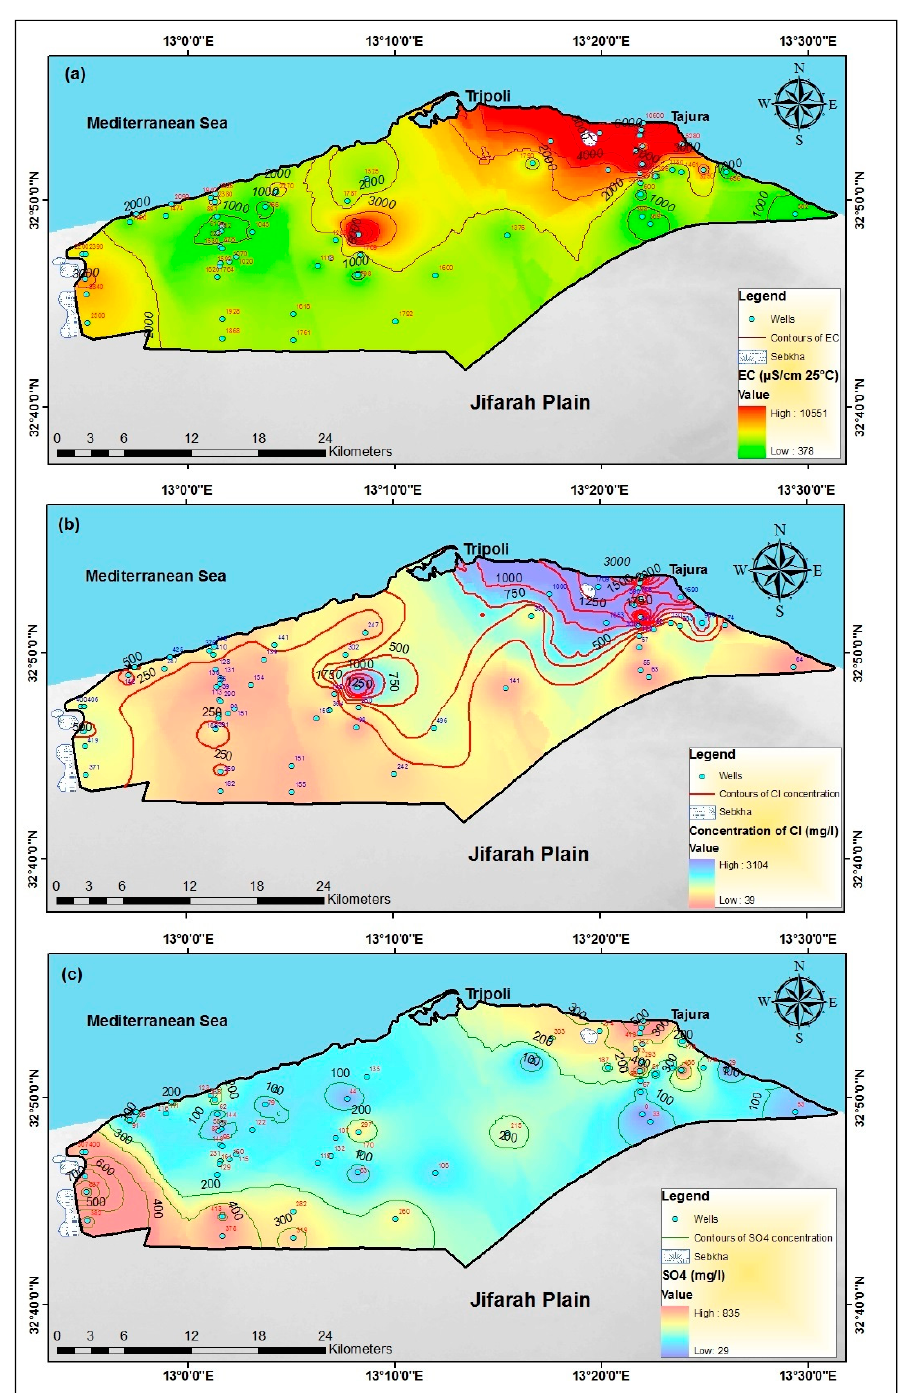
Figure 6. ( a ) Electrical conductivity map of Tripoli; ( b ) map with the spatial distribution of concentrations of Cl − ; and ( c ) spatial distribution of SO 42 − in the upper aquifer of Tripoli.